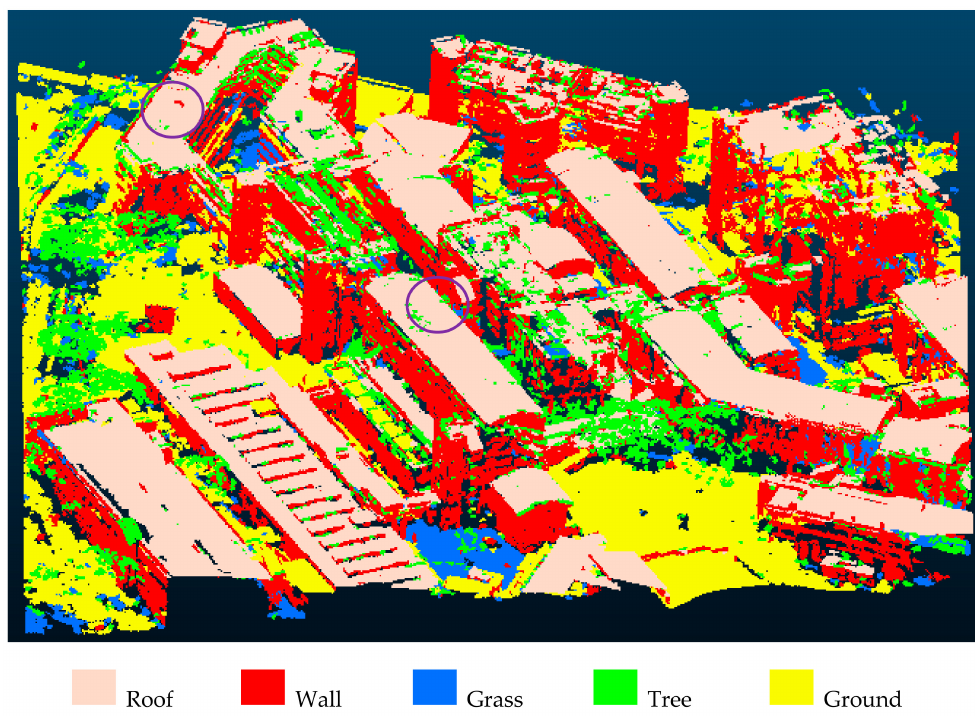
Figure 10. Classification results of the point cloud in Dataset2.